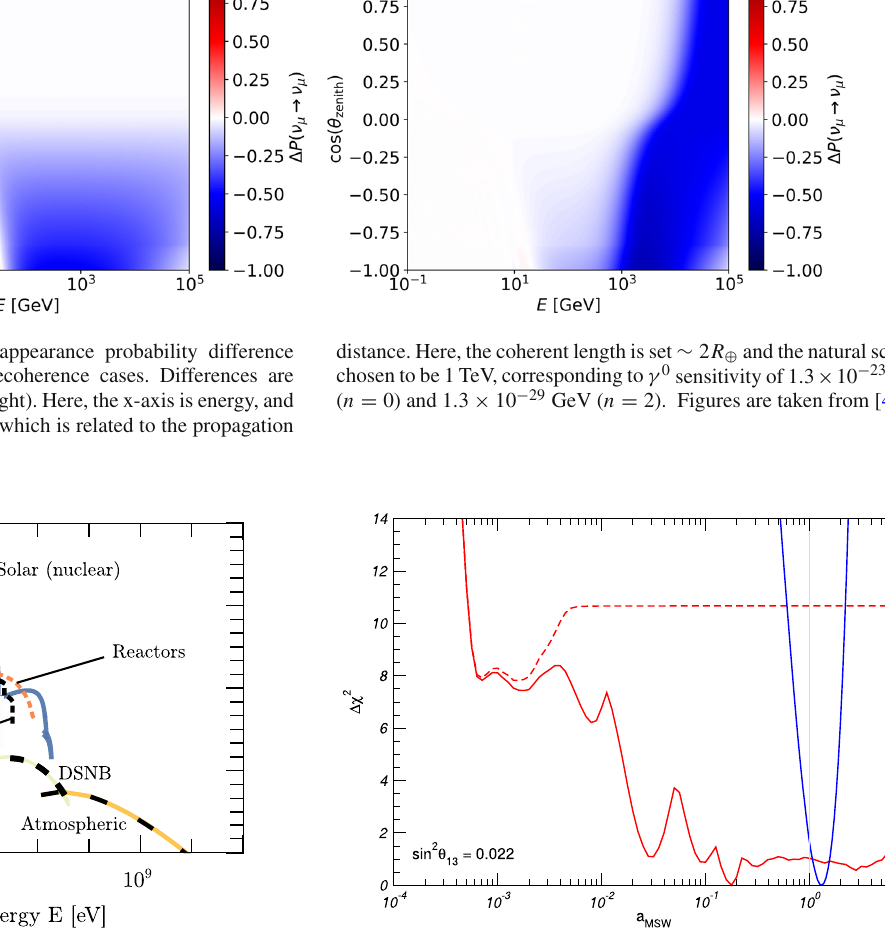
Fig. 10 Neutrino fluxes at Earth, showing that low-energy neutrinos are dominant. We do not show the flux from a galactic supernova, that would peak at neutrino energies ∼ 10MeV and outshine the solar neu- trino flux by several orders of magnitude [469,470]. Figure adapted from Ref. [471]